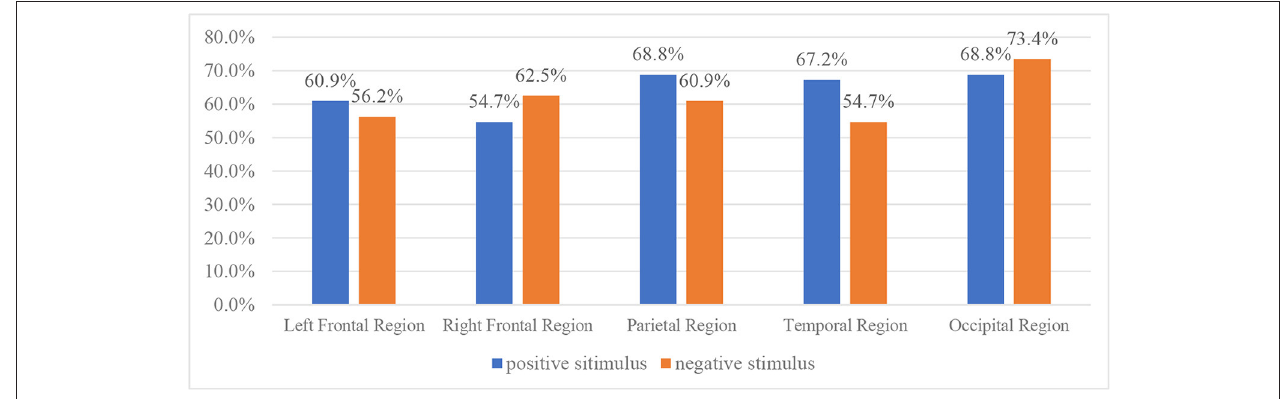
FIGURE 5 | Performance comparison of different brain region features for typically developing (TD)/autism spectrum disorder (ASD) classification.